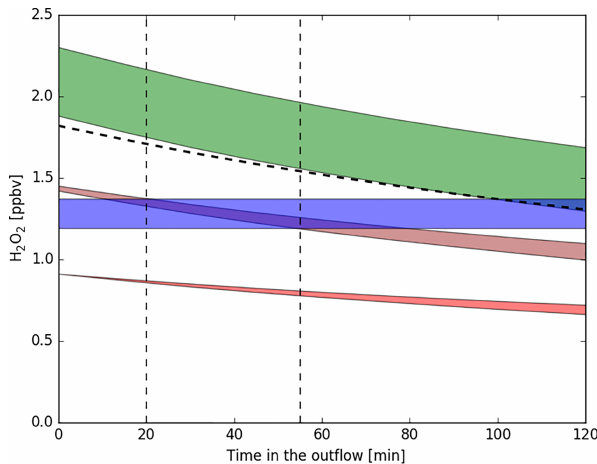
Figure 10. Simulated temporal evolution of H 2 O 2 mixing ratios in the outflow region. Coloured bars show the variance from sensitivity studies with randomly-varied rate constants and concentrations. The blue bar indicates the range of observed values in the outflow. The red curve simulates photochemical change assuming zero transport from the inflow area, while the green curve shows photochemical degradation assuming 100% transport from the inflow area. The dashed line is a sensitivity study assuming an entrainment rate of 25%. The brown curve is the best fit for processing times deduced from the HCHO study (dashed vertical